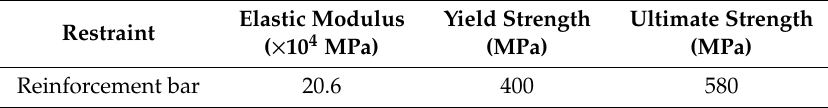
Table 3. Properties of reinforcement bar.